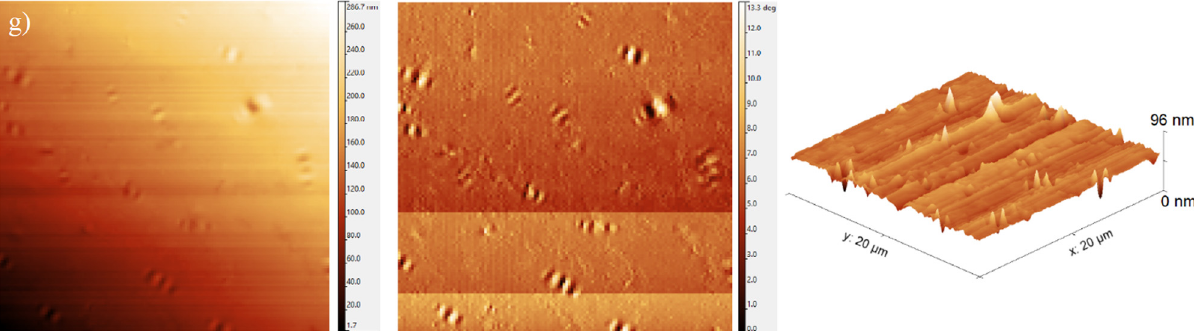
Figure 3: ( a ) AFM 3D view of the surface morphology of asphalt binder, showing bee - like structures after aging that looks like a Toblerone chocolate bar; the bee - like structure is a ff ected by the polarity of asphaltene molecules and is a challenging phenomenon that is directly related to long alkyl chains of asphaltenes, high aromatic components, and microcrystalline waxes. Aging a ff ects the size of the individual bees and their number on the binder surface considerably, and with the increasing size and number, the binder surface sti ff ness increases. ( b ) AFM 2D view of components of bee - like structures. ( c ) Colored single bee; red zone represents saturates – aromatics, violet zone shows asphaltenes – resins, dark blue zone illustrates resins – aromatics, and light blue zone shows saturates – resins content. The scale bar is 500 nm. ( d ) 3D cross - section of asphalt binder and four components of asphalt binder: asphaltenes, resins, aromatics, and saturates. The scale bar is 1 µm. 2D and 3D AFM surface images of binders: ( e ) morphological unaged sample, ( f and g ) short - term and long - term aged samples, respectively; at three di ff erent modes: center row, phase image; left and right rows, 3D and 2D surface topography